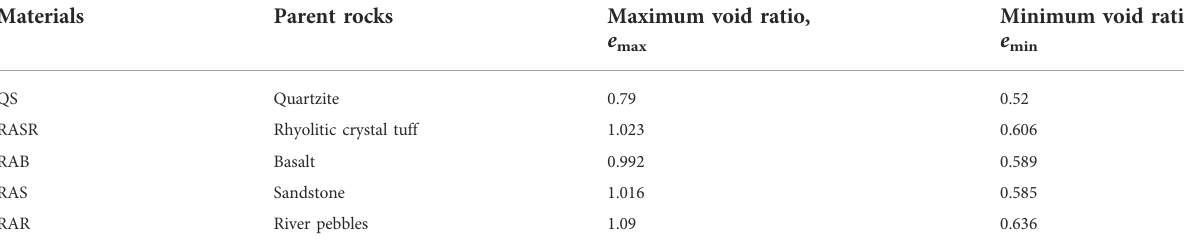
TABLE 1 Properties of QS and RA samples.